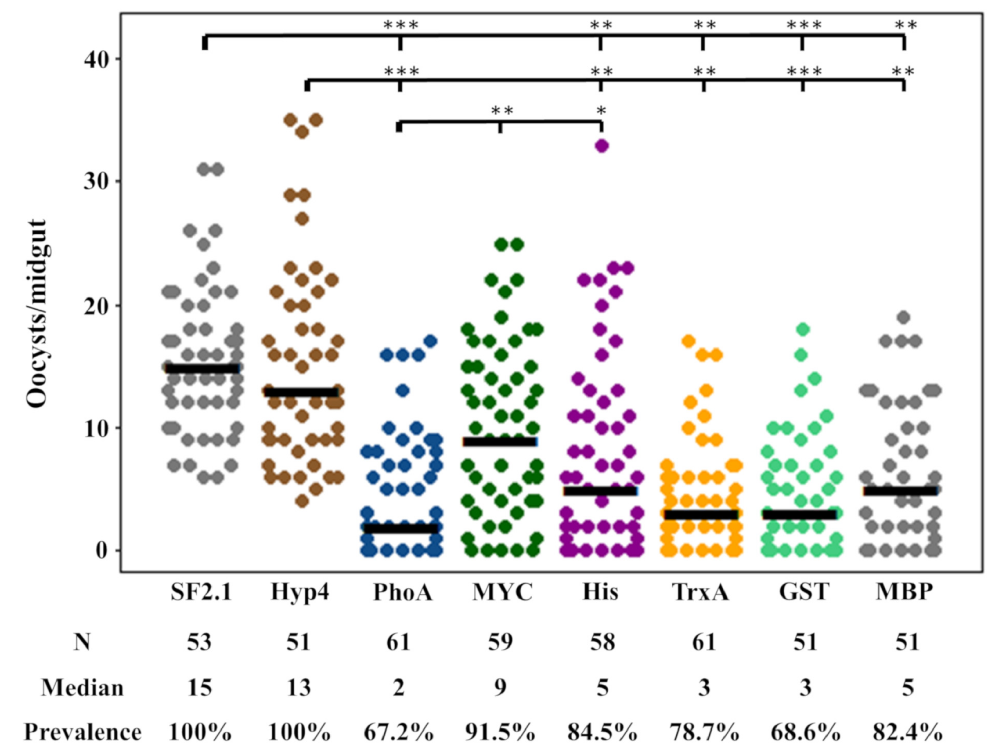
Fig 4. Suppression of P . berghei development by paratransgenic Asaia strains. In four separate trials, oocysts were counted in mosquitoes infected with Asaia strains that were fed on a P . berghei infected mouse. Each dot represents an individual midgut and the number of P . berghei oocysts it contained. Prevalence is the fraction of midguts with at least one oocyst. SF2.1 is the wild type Asaia strain (negative control), Hyp4 is the Asaia strain releasing only alkaline phosphatase (negative control), and PhoA is a previously developed scorpine antiplasmodial strain with alkaline phosphatase as the fusion partner protein (positive control). All antiplasmodial strains significantly reduced the median number of oocysts (horizontal bars) compared to the wild-type strain (quantile regression, P < 0.01), while only the Myc and MBP antiplasmodial strains had a significantly higher median number of oocysts compared to the PhoA strain (quantile regression, P < 0.02161). The prevalence of infection was also significantly different between the wild-type and all antiplasmodial strains except for the Myc strain ( χ 2 , 1 df). Only the Myc and His antiplasmodial strains had a significantly higher prevalence of infection compared to the PhoA strain ( χ 2 , 1 df). There was no significant difference between the wild-type and Hyp4 negative controls. P -values: � P < 0.05, �� P < 0.01, ��� P <